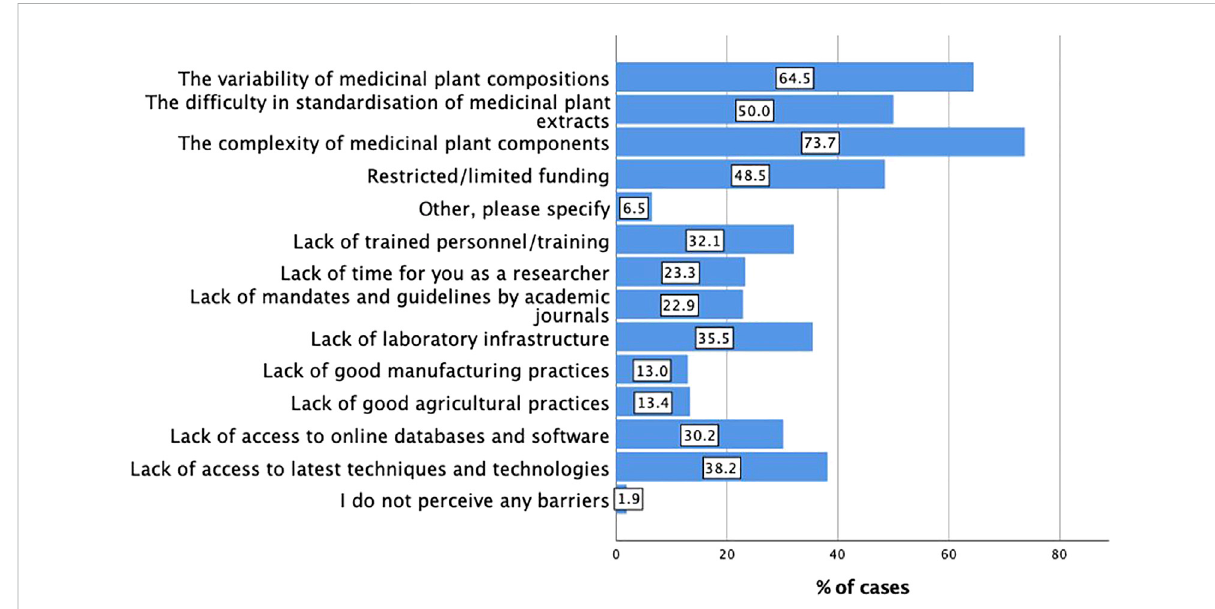
FIGURE 3 Core barriers in extract characterisation (n = 262; multiple responses possible).